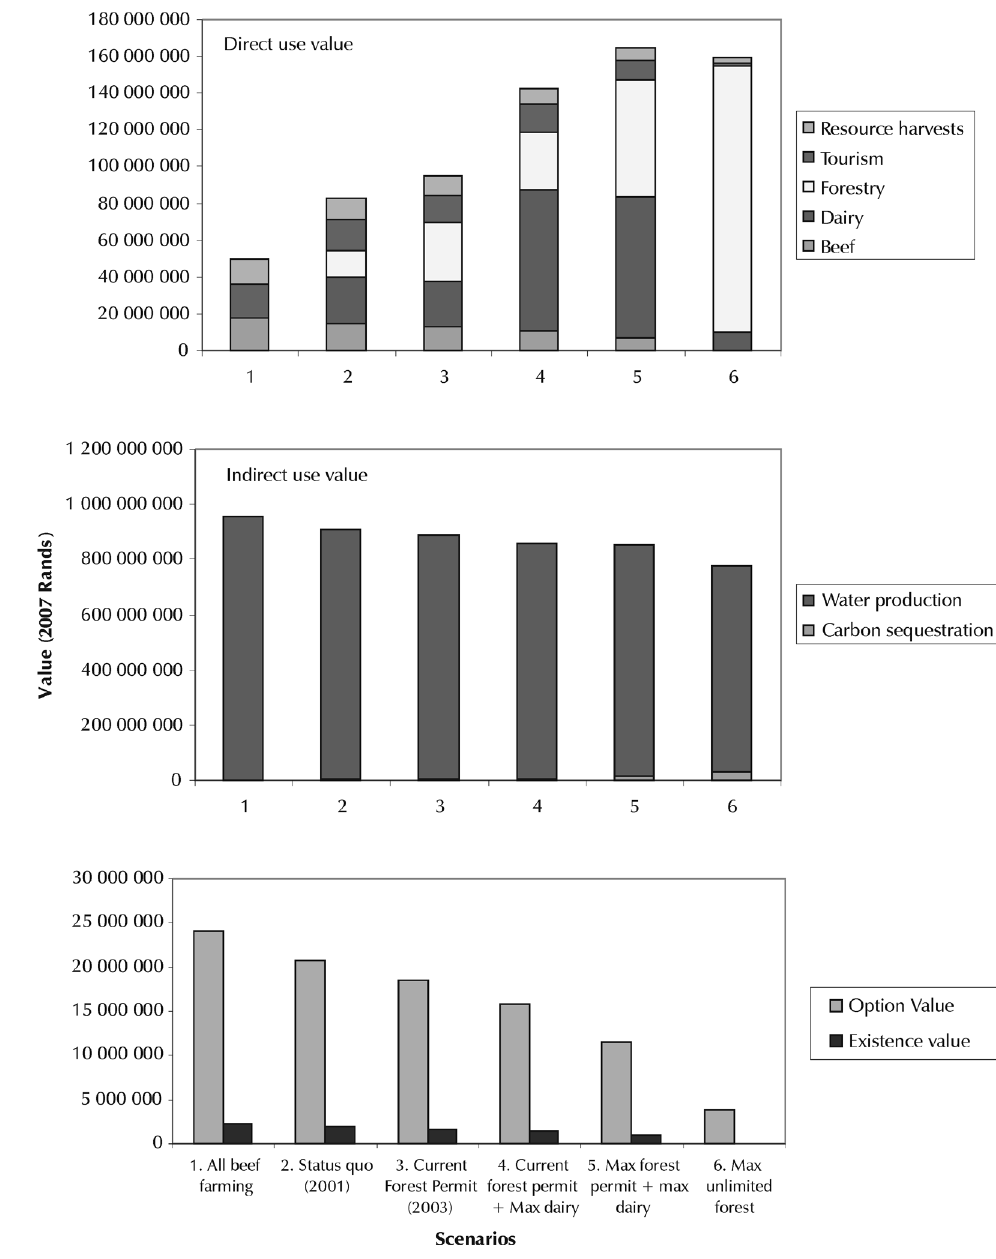
Estimated direct use values, indirect use values, option value and existence value of the area under different scenarios in terms of value added to the economy, 2007 rands. Note that the option value is partial (immediate potential use of animals and plants) and does not include future potential exploitation of genetic